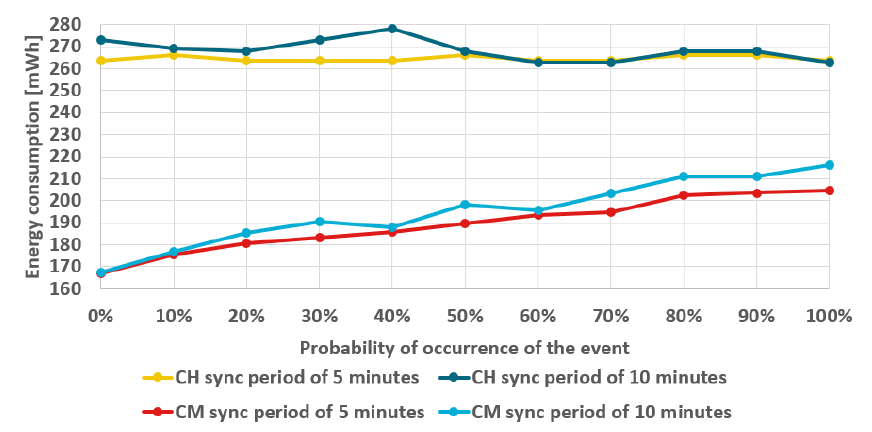
Figure 5. Impact of the synchronization period on the energy consumption of sensor